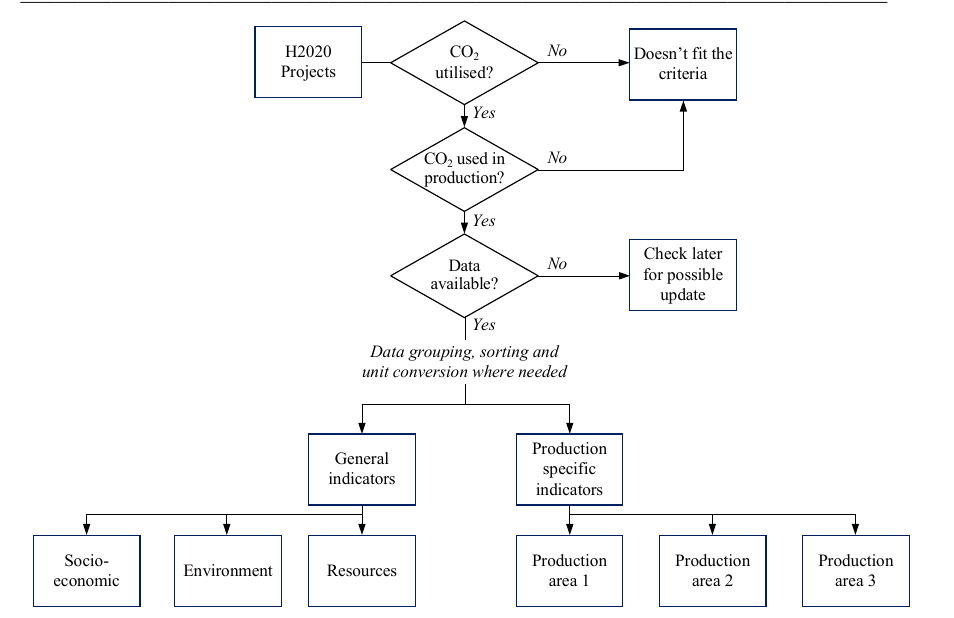
Fig. 4. Algorithm of H2020 project processing and KPI database